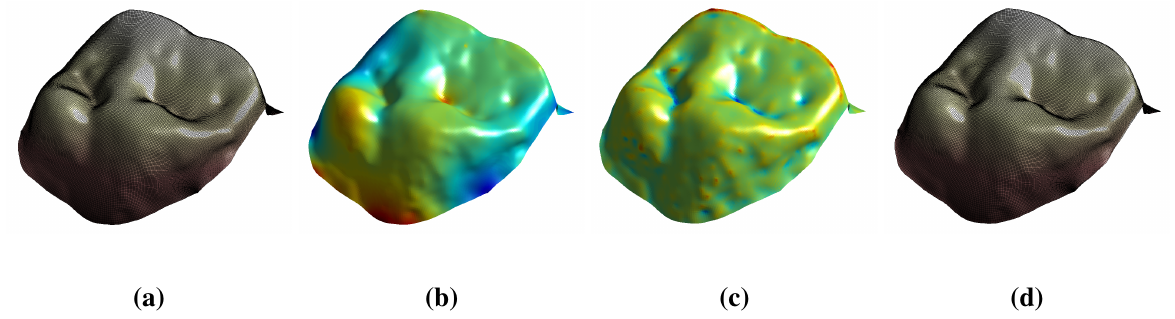
Figure 4. ( λ, H ) representation of a human tooth. ( a ) The original mesh of a tooth. By finding the conformal parameterization of the tooth to a rectangular conformal parameter domain, we calculate the conformal factor, as shown in ( b ). ( c ) The mean curvature of the tooth. By using λ and H , we can reconstruct the tooth, as shown in ( d ).